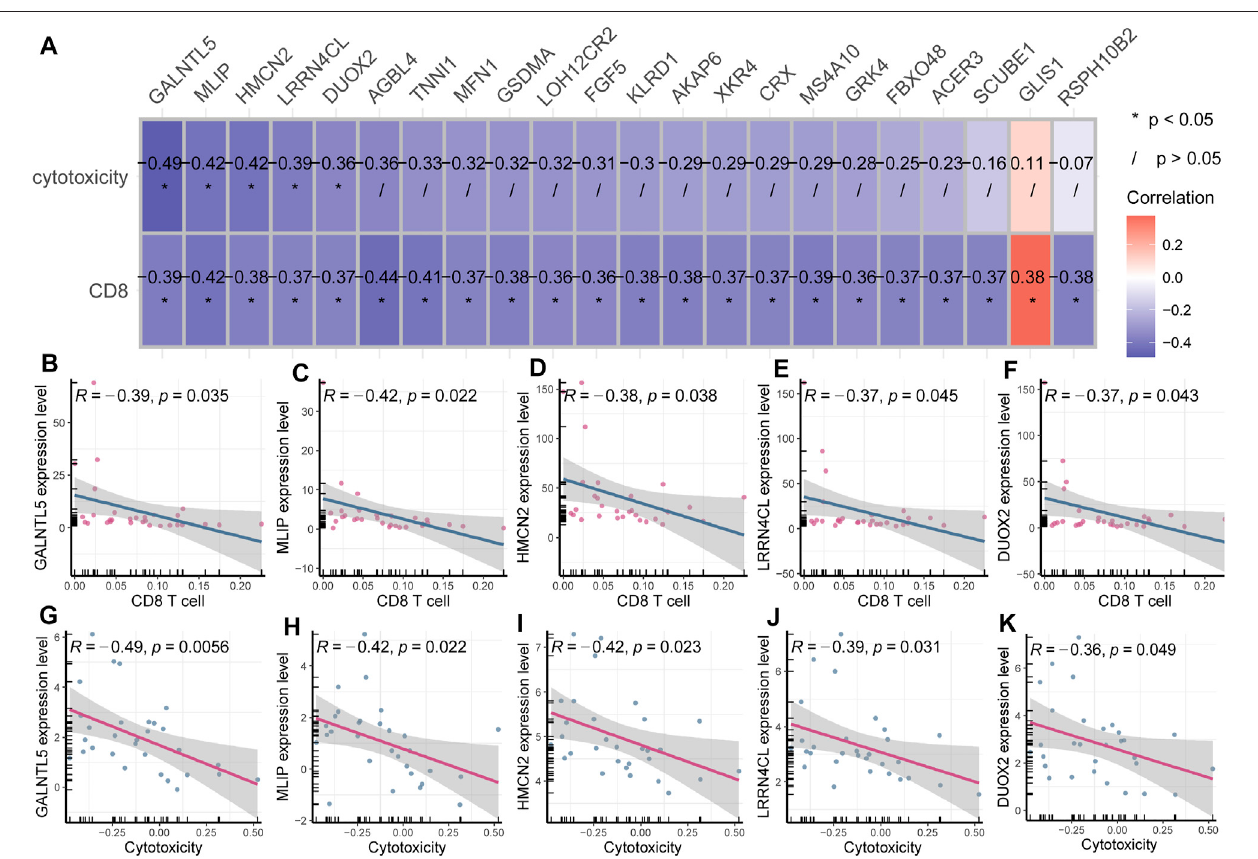
FIGURE 4 | Identi fi cation of cytotoxicity-associated key genes in breast cancer (A) Heatmap plot displayed key genes associated with CD8 + T cell in fi ltration and cytotoxicity. (B – F) GALNTL5,MLIP,HMCN2, LRRN4CL and DUOX2 wereinversely associatedwithCD8 + Tcellin fi ltration. (G – K) GALNTL5,MLIP,HMCN2, LRRN4CL and DUOX2 were also negatively correlated with immune cell